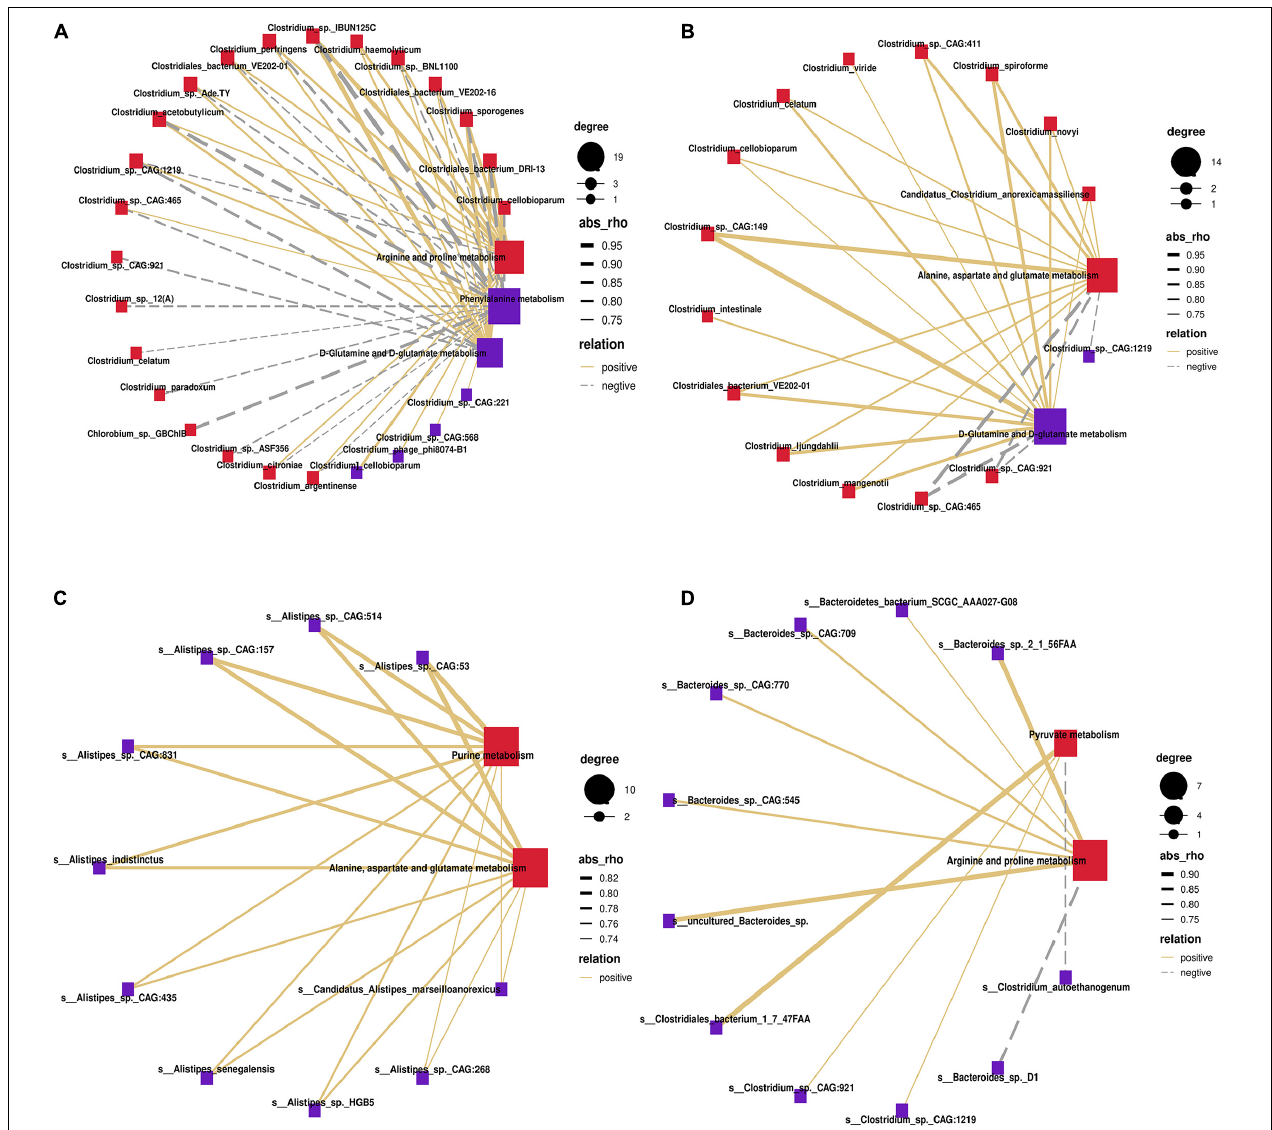
FIGURE 6 | Correlation of differential bacteria at the species level with enrichment pathway. Spearman’s correlation network showing relationships between microbiota and different metabolites enrichment pathways in rumen (A) , reticulum (B) , omasum (C) , and abomasum (D) . Only partly strong correlations ( R > 0.7 or R < − 0.7, P < 0.05) were showed in the correlation networks. The solid and dashed lines indicate positive and negative correlations,